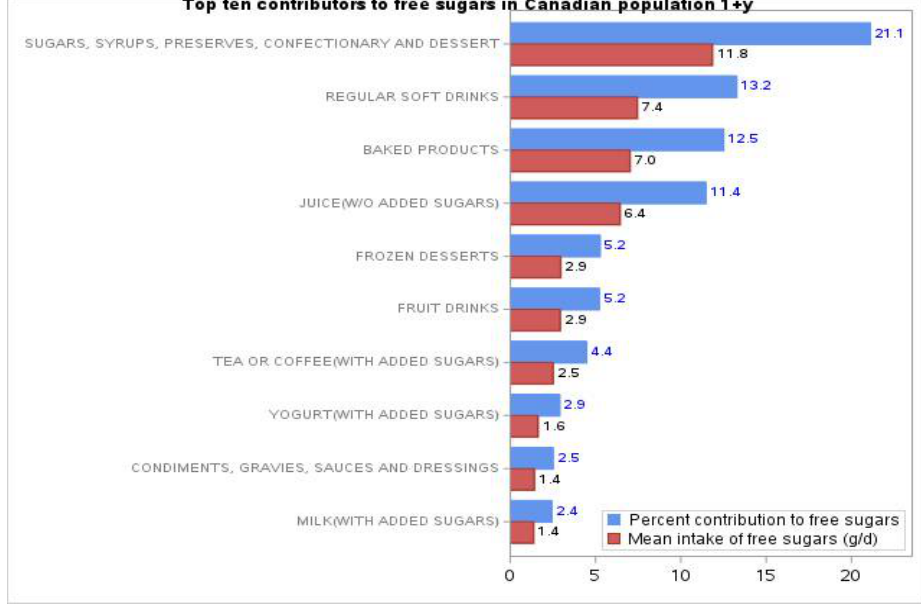
Figure 3. Top 10 contributors of free sugar intakes in Canadians 1 year or older.